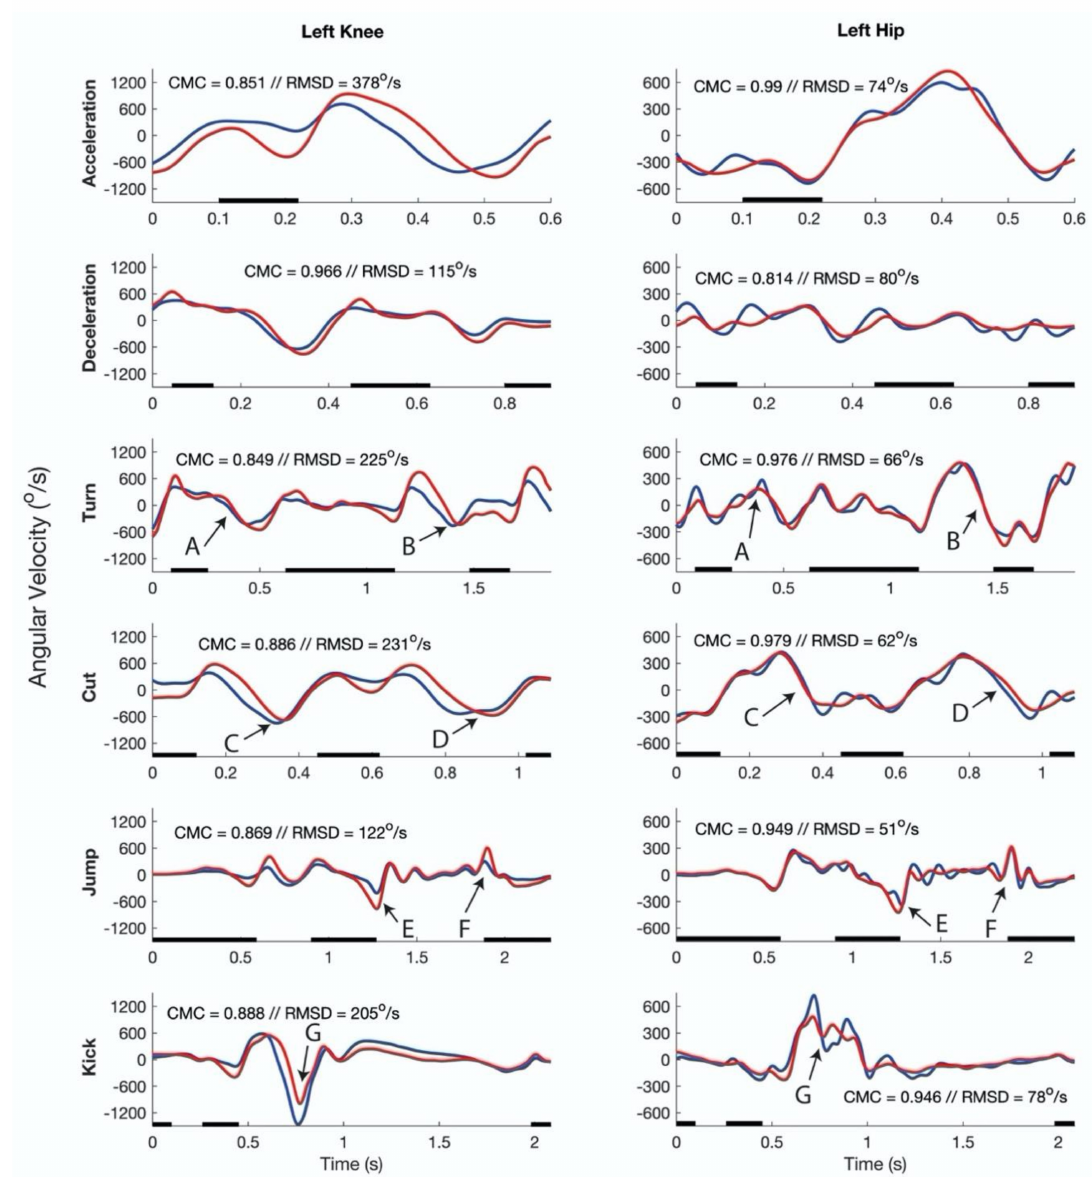
Figure 5. Typical results joint flexion / extension angular velocities. Example of joint flexion / extension angular velocities for the inertial-based motion analysis system (blue line) and the optoelectronic motion analysis system (red line) of all movements performed at maximum intensity by one participant. The black lines indicate when the foot is in contact with the ground. For each joint and movement, the coe ffi cient of multiple correlation (CMC) and root mean square di ff erence (RMSD) is indicated in the respective graph. The arrows indicate events and have the following meaning: A = turn initiation, B = turn completion, C = cut initiation, D = cut completion, E = push-o ff , F = landing, G = moment of ball